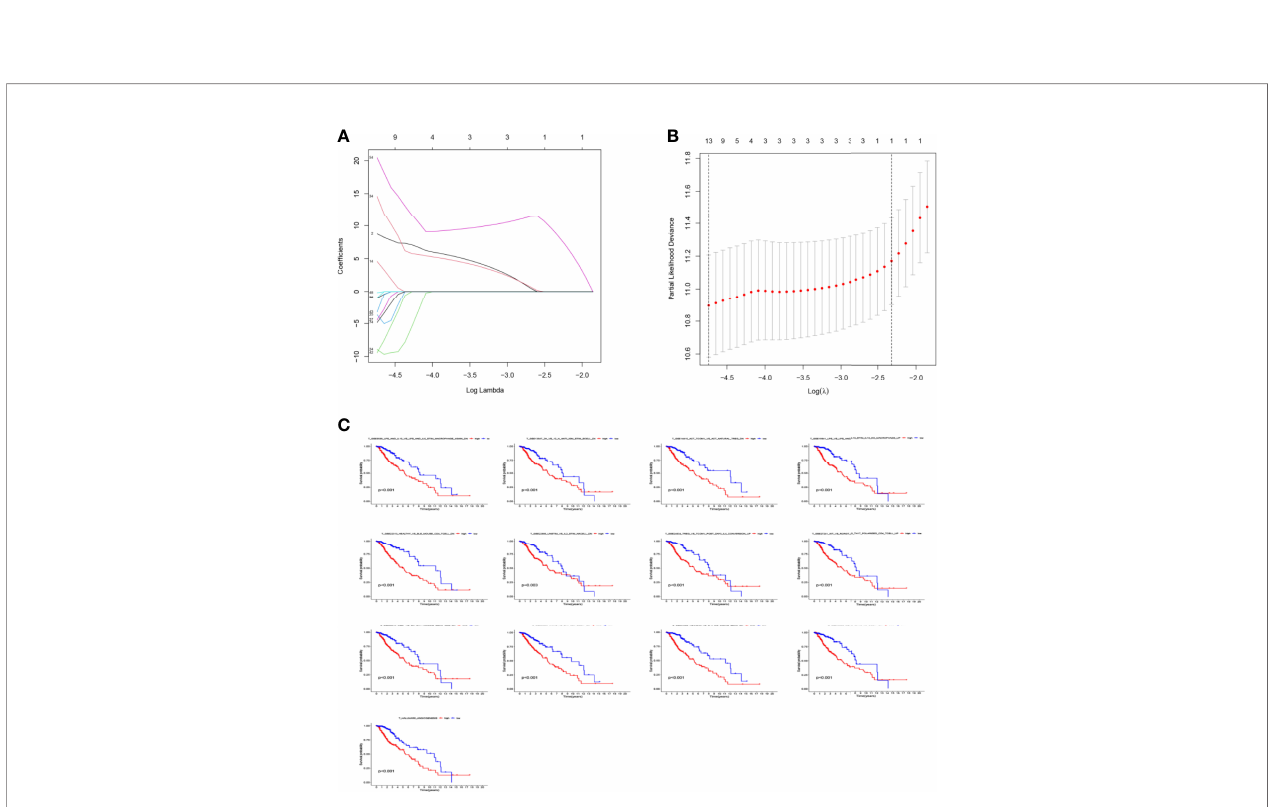
FIGURE 7 | Prognostic gene sets in glioma. (A) LASSO coef fi cient pro fi les (y-axis) of the gene sets and the optimal penalization coef fi cient ( l ) via 3-fold cross-validation based on partial likelihood deviance. (B) The dotted vertical lines represent the optimal values of l . The top x-axis has the numbers of gene sets, whereas the lower x-axis revealed the log ( l ). (C) High enrichment scores in glioma were associated with poor overall survival. P-values <0.05 were considered statistically signi fi